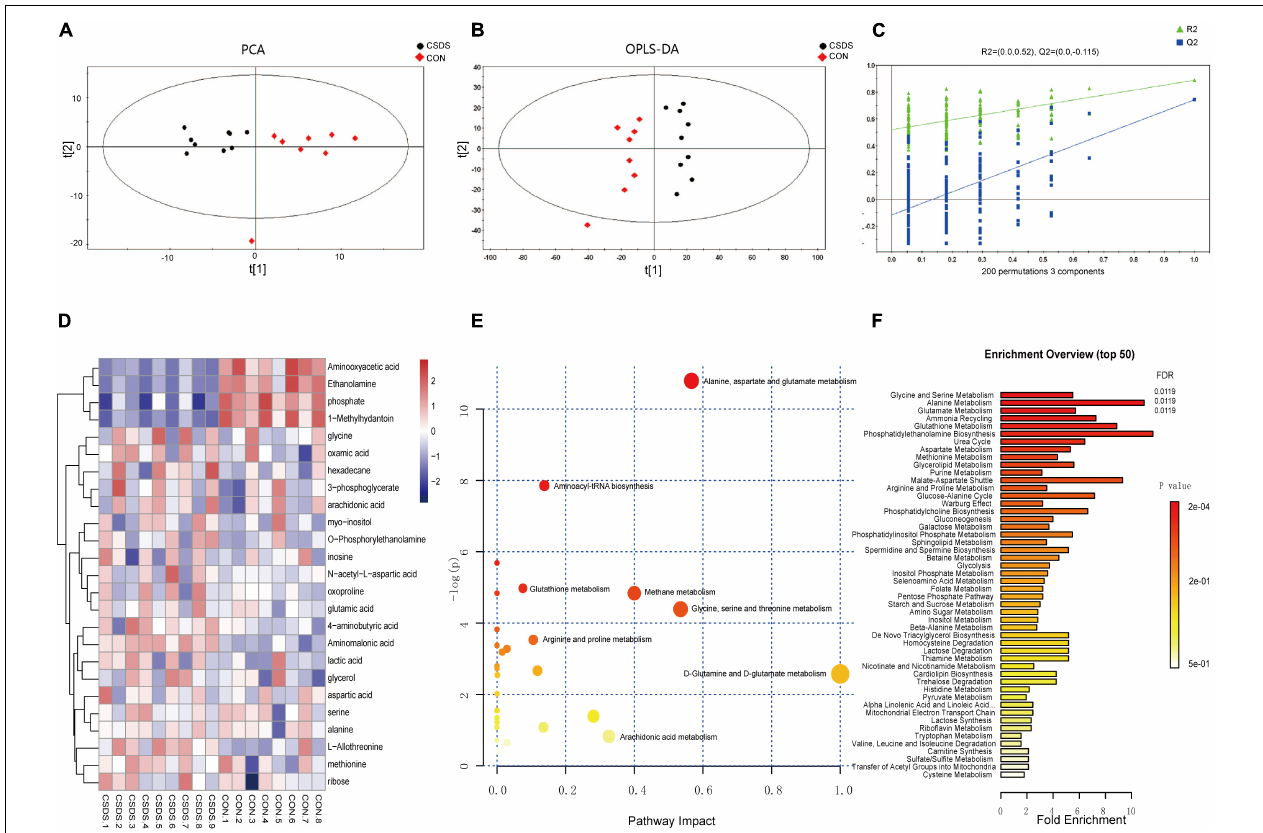
FIGURE 2 | Metabolomic analysis of hippocampi from CSDS and CON group rats. (A) Principal component analysis (PCA) scores plot of CSDS group rats (black dots) and CON group rats (red diamonds). (B) Orthogonal partial least-squares discriminant analysis (OPLS-DA) scores of CSDS group rats (black dots) and CON group rats (red diamonds). (C) A 200-iteration permutation test showing the original values (top right) of R 2 (green triangles) and Q 2 (blue squares) was significantly higher than corresponding permuted values (bottom left), demonstrating the OPLS-DA model was not-overfitted. (D) Heatmap of 25 differentially expressed metabolites in the CSDS model: rows, metabolites; columns, samples. (E) Overview of pathway analysis based on metabolite alterations. (F) Overview of enrichment analysis based on metabolite